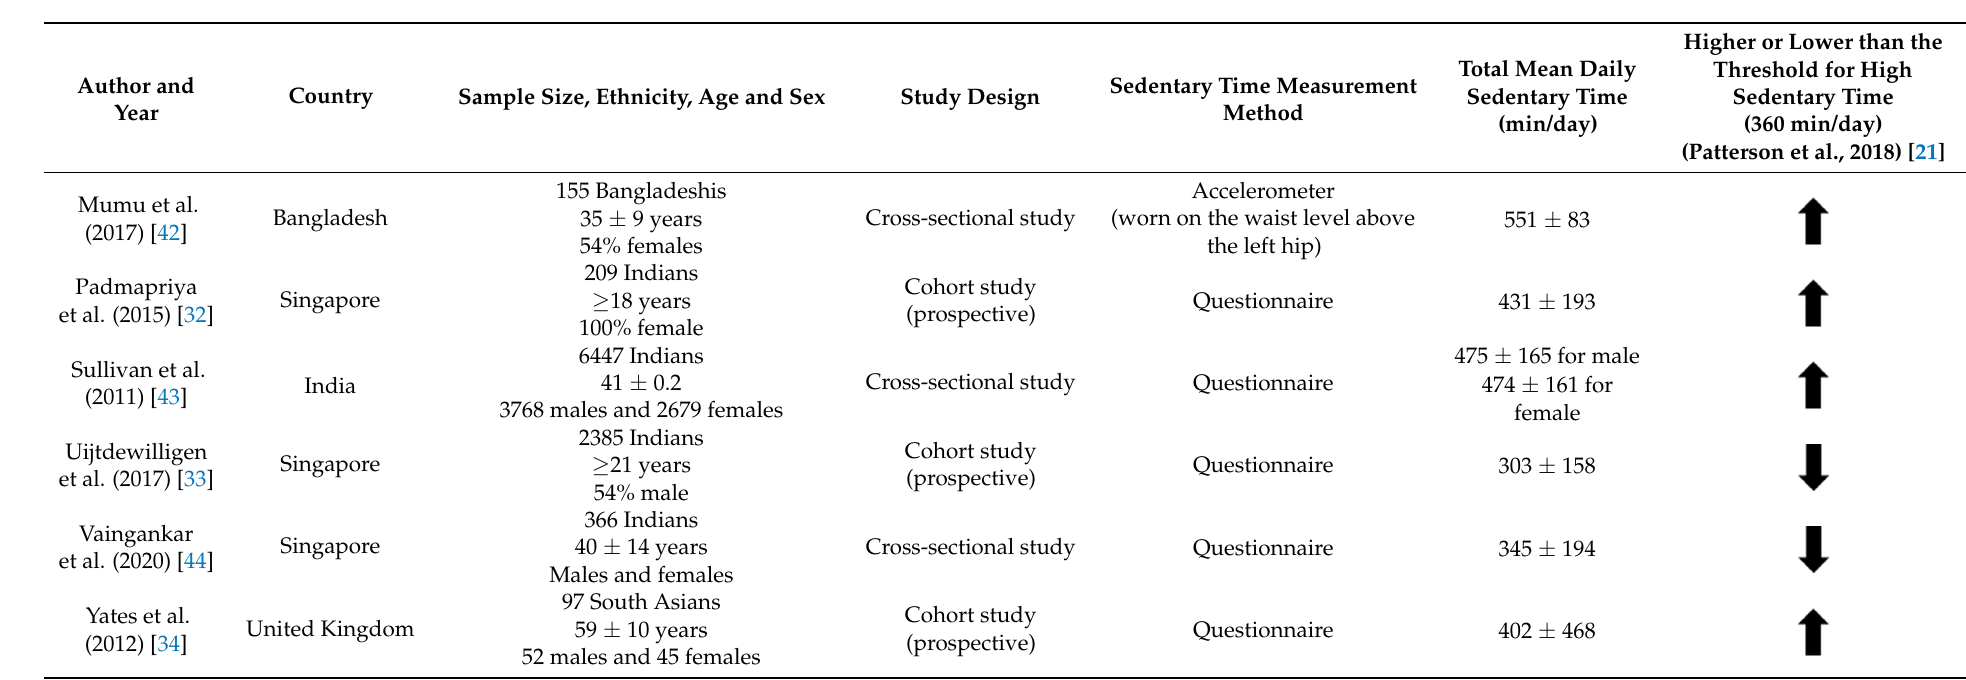
Table 2. Overview of study characteristics.